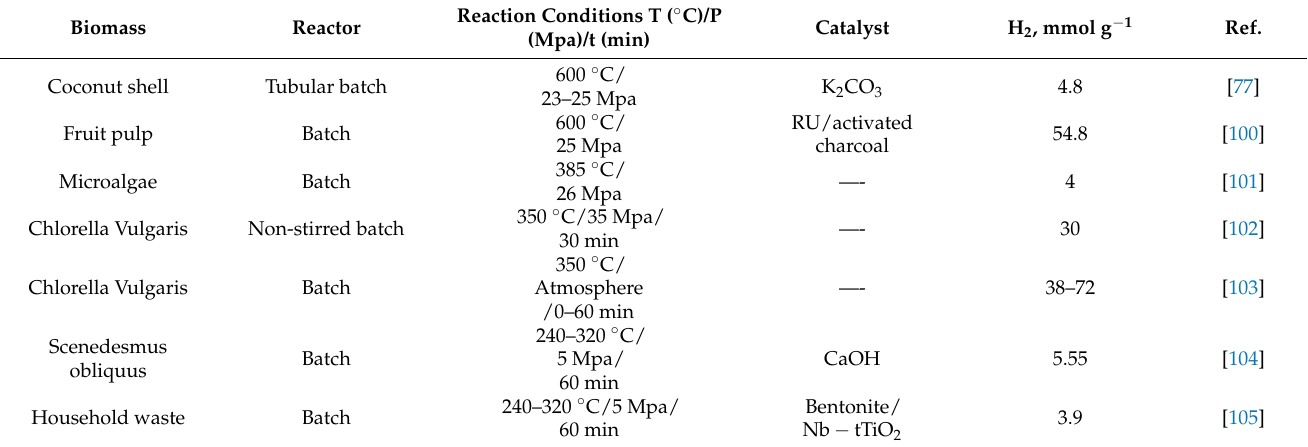
Table 4. Operating conditions and results obtained through biomass